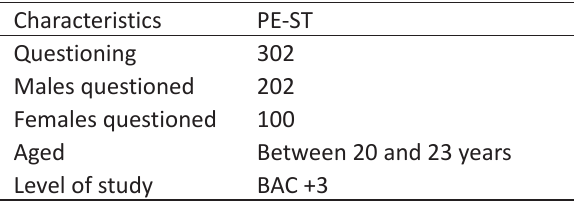
Table 1: Sample of Tunisian PE-ST